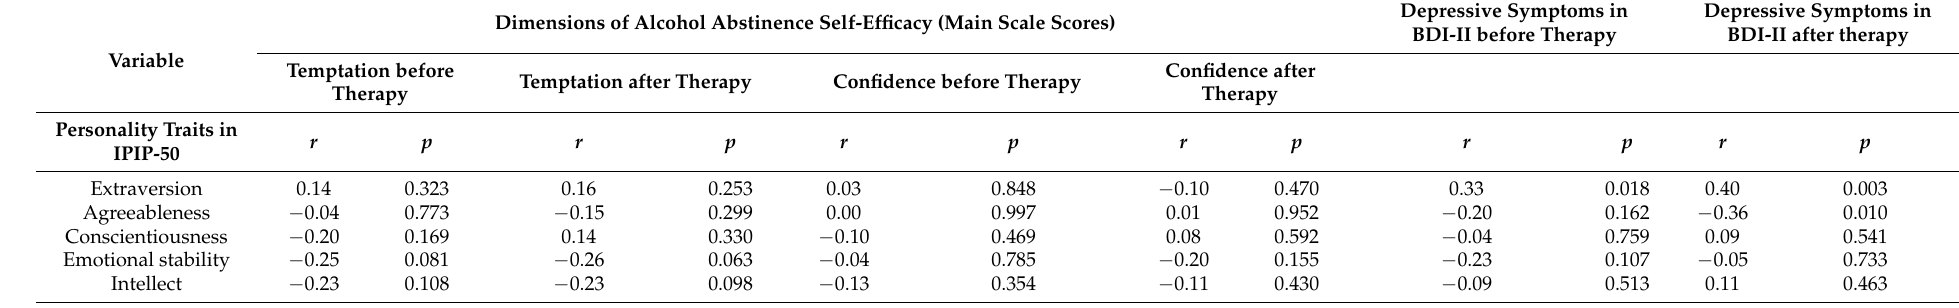
Table 3. Relationships between personality traits, dimensions of self-efficacy, and depressive symptoms in the investigated group before and after therapy. Dimensions of Alcohol Abstinence Self-Efficacy (Main Scale Scores) Variable Temptation before Temptation after Therapy Confidence before Therapy Therapy Personality Traits in